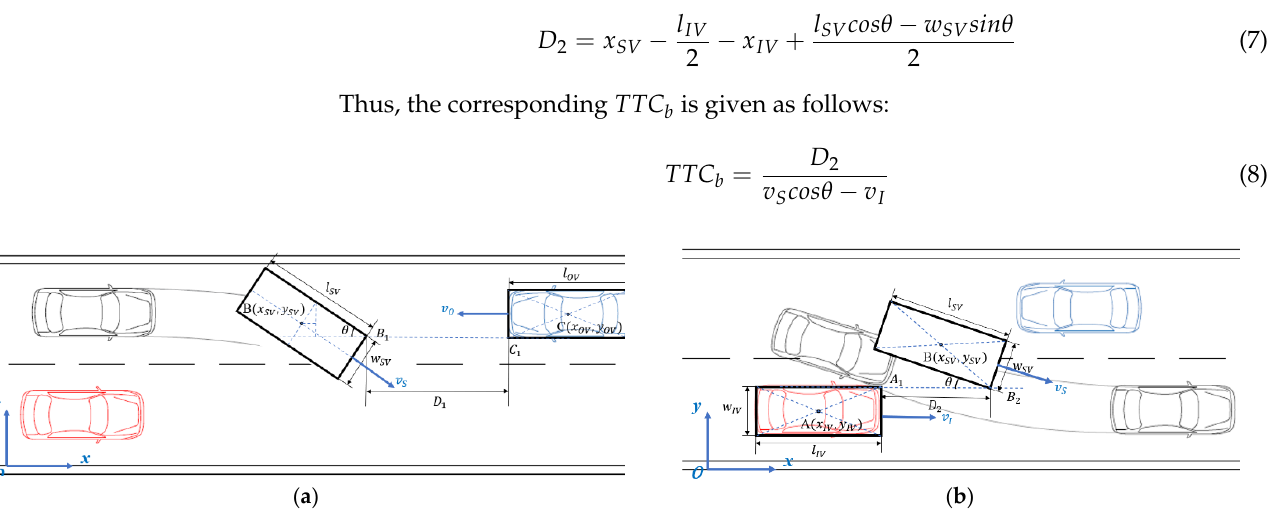
Figure 3. Variables of critical position ( a , b ) for calculating TTC of a driver during his/her second phase of overtaking on a two-lane highway.